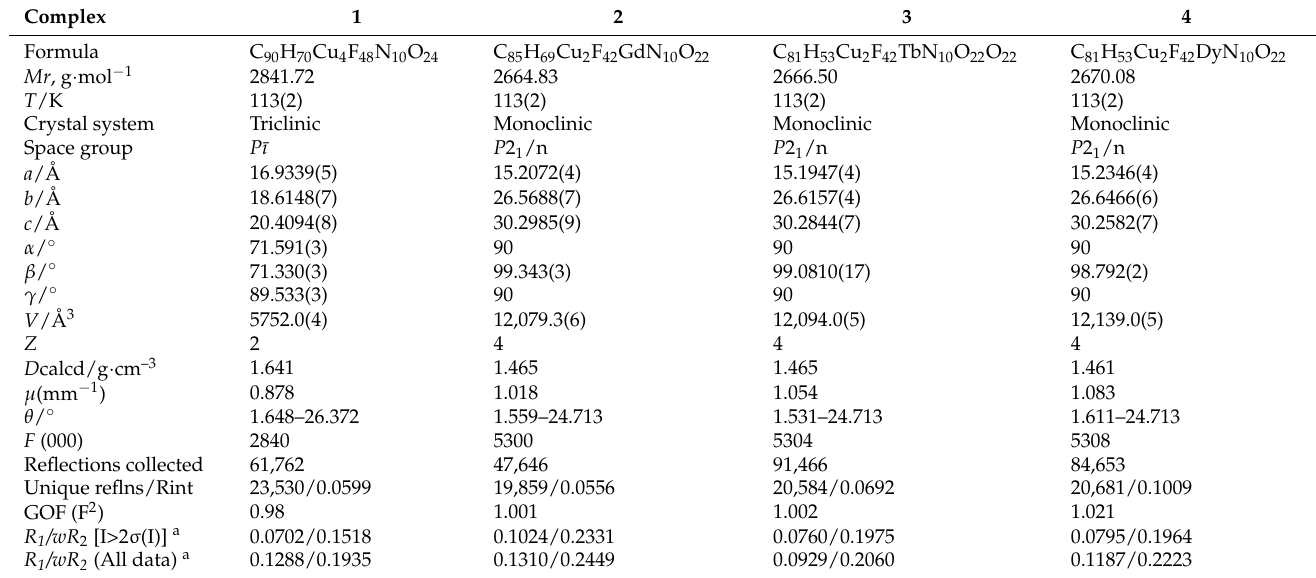
Table 2. Crystallographic data for complexes 1 – 4 .